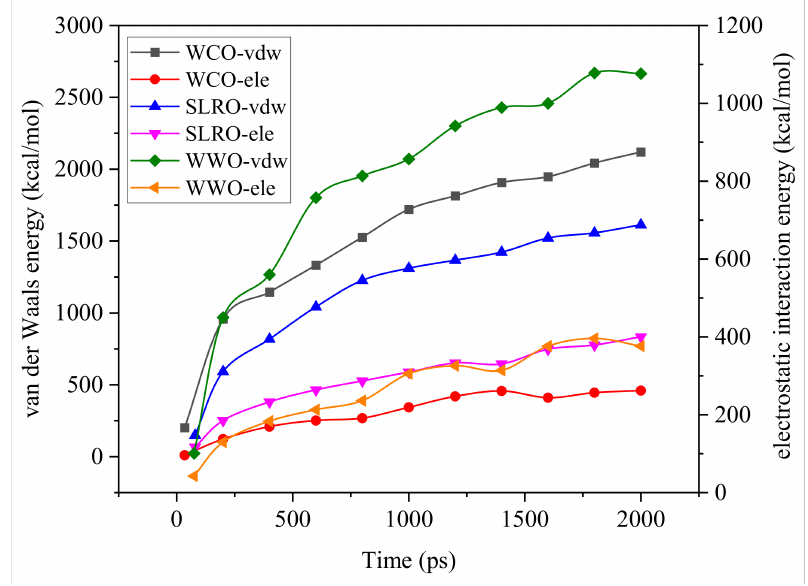
Figure 15. The E vdw and E ele between bio-oil droplets and aged bitumen